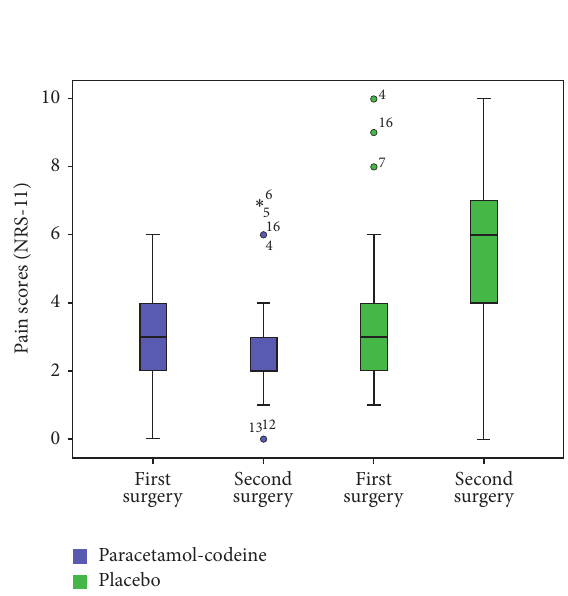
Data expressed as the mean ± standard deviation. Asterisk indicates a significant difference.